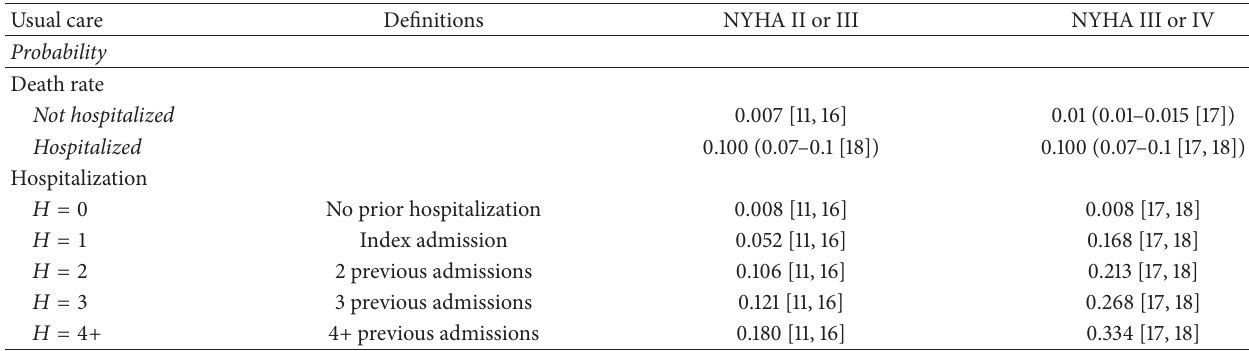
Figure 2: Markov model diagram. Table 1: Probability of mortality and hospitalization.